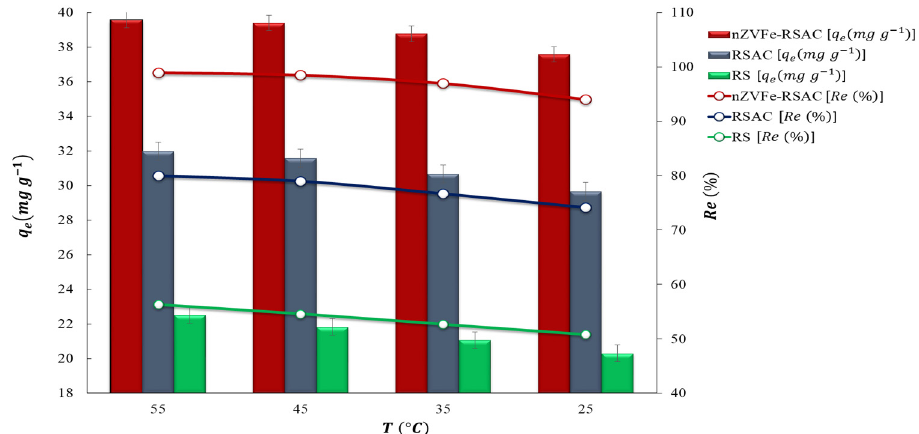
Figure 11. Effect of temperature on the adsorption of Pb(II) onto RS, RSAC, and nZVFe–RSAC (at